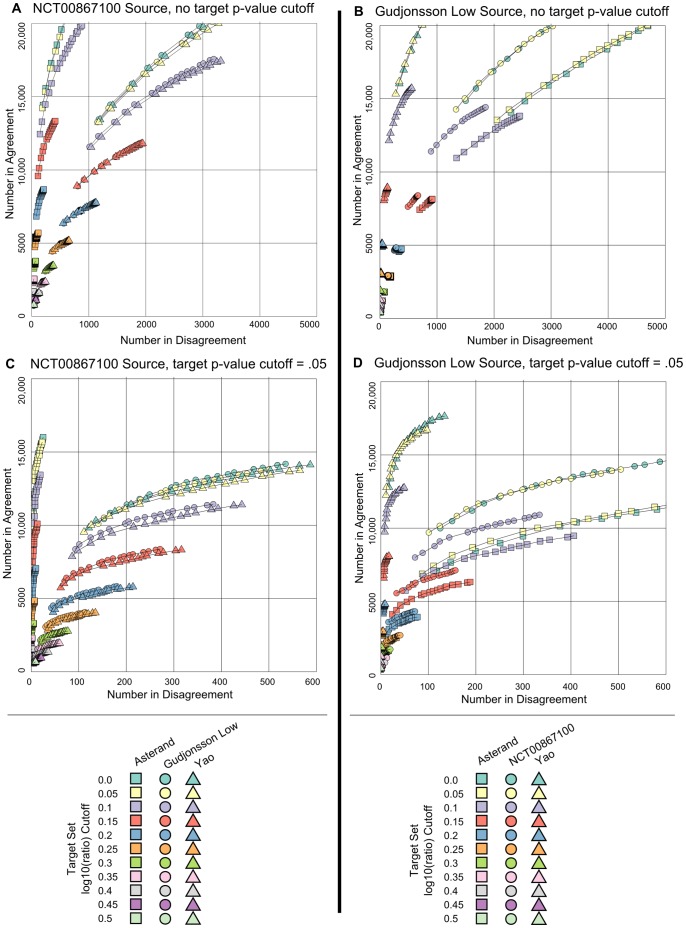
Effect of log10(ratio) and p-value Cut-offs on Overlap of Differentially Expressed Probe Sets.Effects are shown with source sets (A,C) NCT00867100 and (B,D) Gudjonsson low. (A, B): Number of probe sets agreeing and disagreeing for log10(ratios) from 0 to 0.5 in increments of 0.05 and p-values up to 0.2 in increments of 0.01 in the source set without cut-offs in the target set, (C, D): Number of probe sets agreeing and disagreeing from an analysis using log10(ratios) from 0 to 0.5 in increments of 0.5 and p≤0.05 in the source set and p-values up to 0.2 in increments of 0.01 in the target set are shown. Note: X-axis scales in (A, C) differ from those in (B, D).